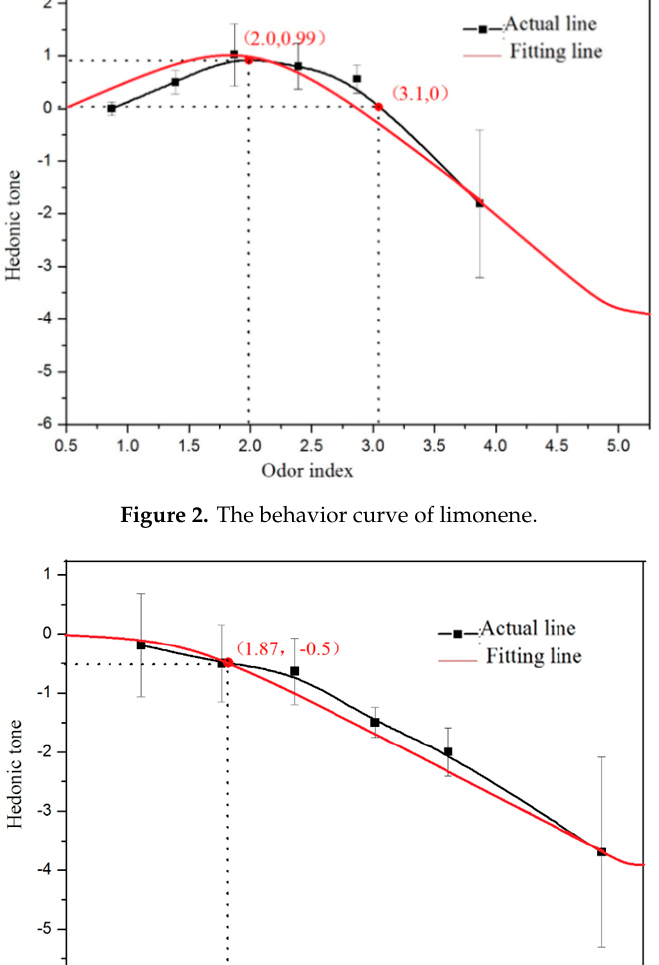
Figure 4. Comparison of the behavior curves of the three typical odorants.